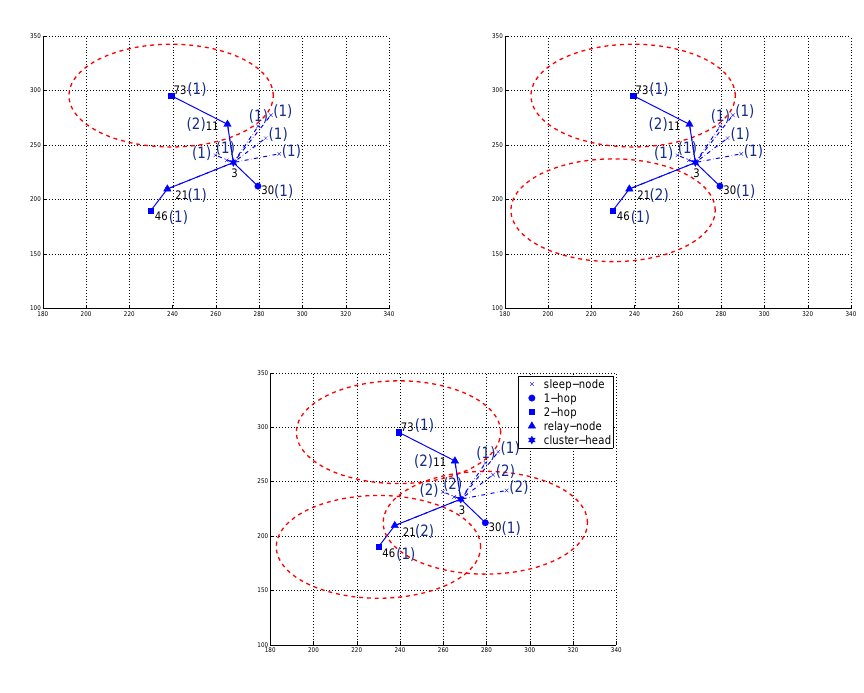
Figure 4. The round ID updating process of the DASA algorithm; the ( · ) represents the round